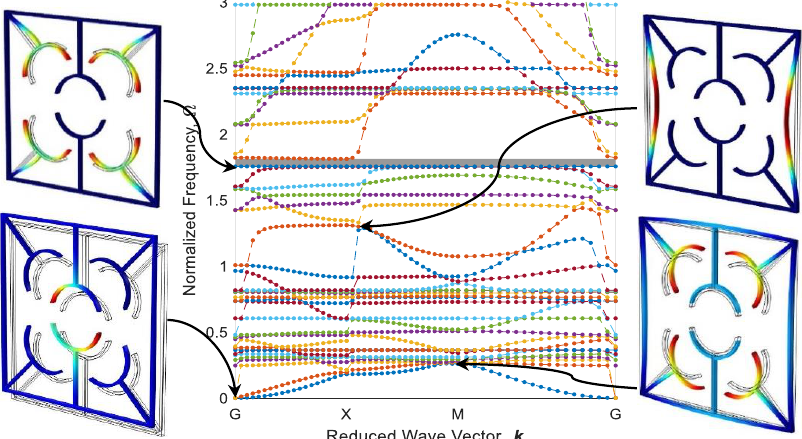
Figure 13. Band structure and mode shapes of the diagonal structure with active elements printed at 20 mm/s after the heating – cooling process.